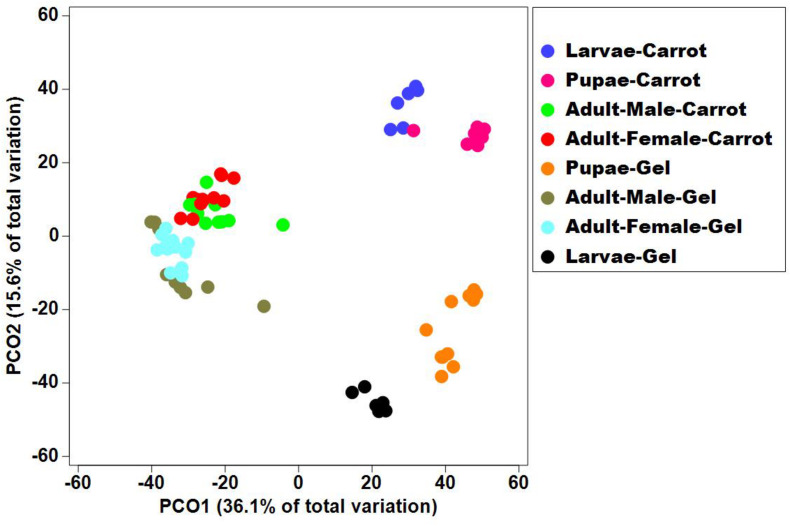
Principal co-ordinate analysis of the bacterial communities in the Qfly developmental stages at G5 reared on carrot diet and gel diet.